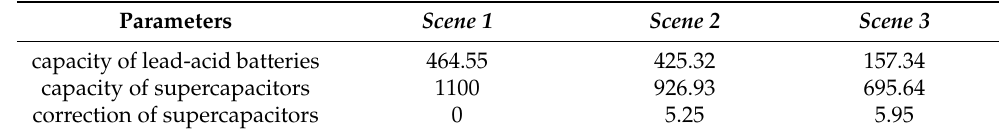
Table 3. Configuration results in the three scenarios (KW).